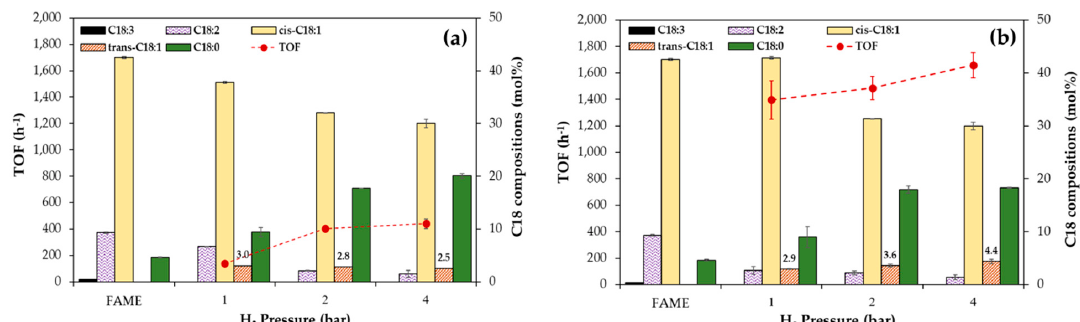
Figure 7. Effect of H 2 pressure on the degree of TOF and C18 compositions in the H-FAME obtained from the partial hydrogenation of palm oil-derived FAME over ( a ) 30 wt% Ni/SB and ( b ) 30 wt% Ni/SF catalysts at 140 °C.